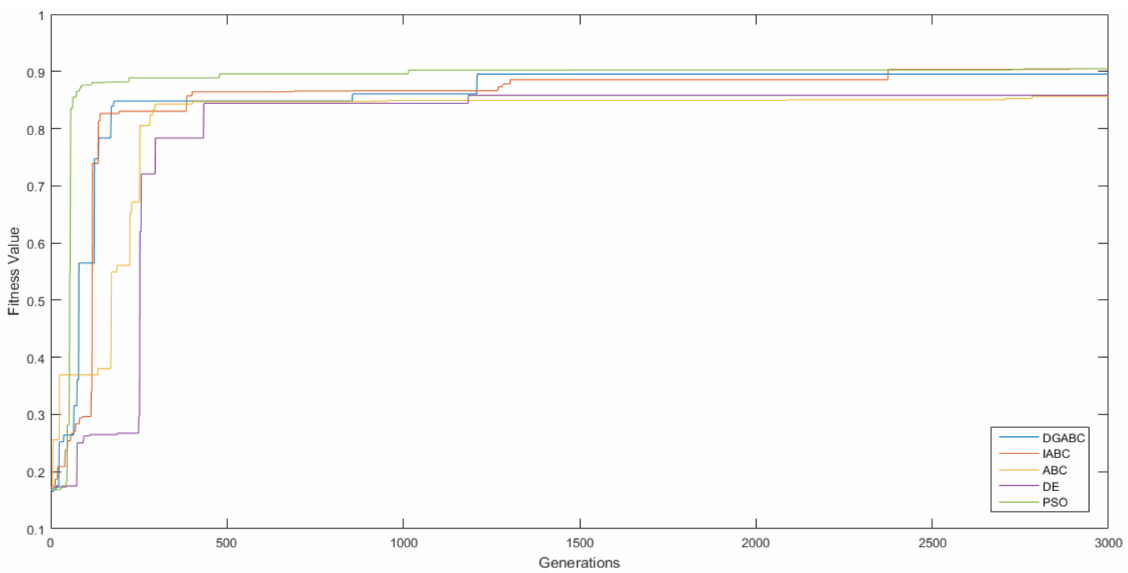
Figure 22. Learning curves of wall-following control in various algorithms.